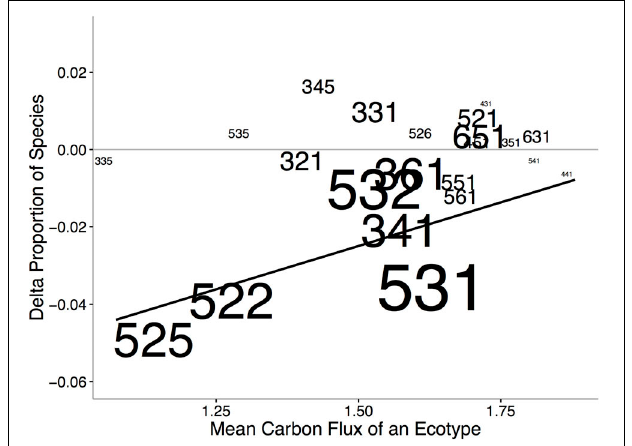
FIGURE 5 | Changes in the proportion of ecological modes between the Atlantic and Pacific Oceans verses the mean carbon flux of the ecological mode. Increases in values indicate increased representation in the Pacific and decreased representation in the Atlantic. Size of text indicates ecological-mode proportion in the data set. Numbers refer to unique functional combinations on three ecological mode axes, tiering, motility, and feeding (see Figure 4 caption for details of numbers). We find that HET associated with higher POC fluxes occur in greater proportion in the Pacific Ocean and, conversely, LET occur in greater proportion in the Atlantic. From McClain et al. (2018). Dashed line represents in proportions in the Atlantic and Pacific Oceans. Solid line indicates significant regression